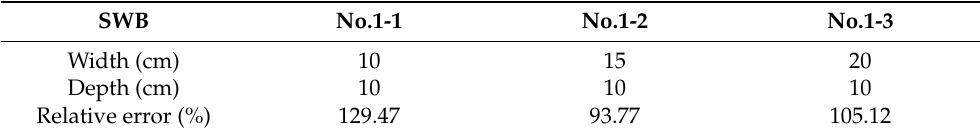
Table 1. The width relative error of SWBs at different depths (simulation scenario 2).